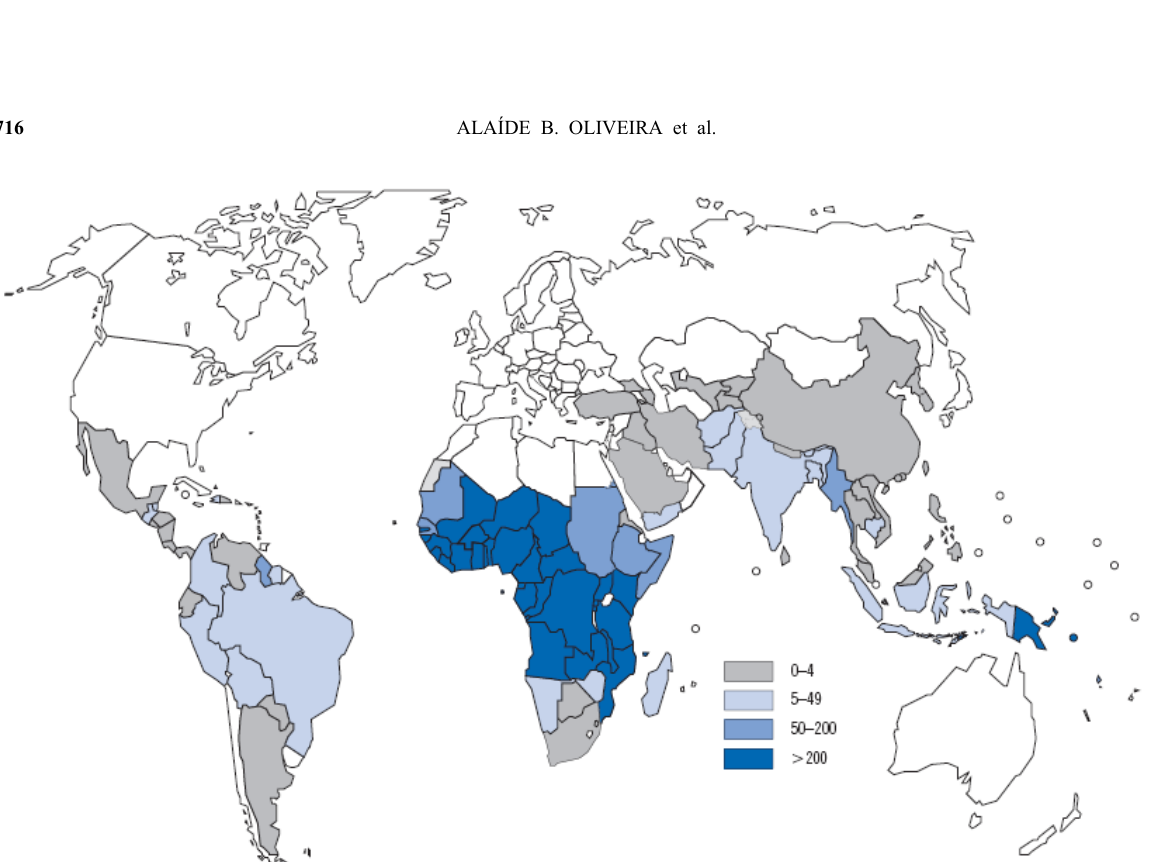
Fig. 1 – Estimated incidence of malaria per 1000 population, 2006 (WHO